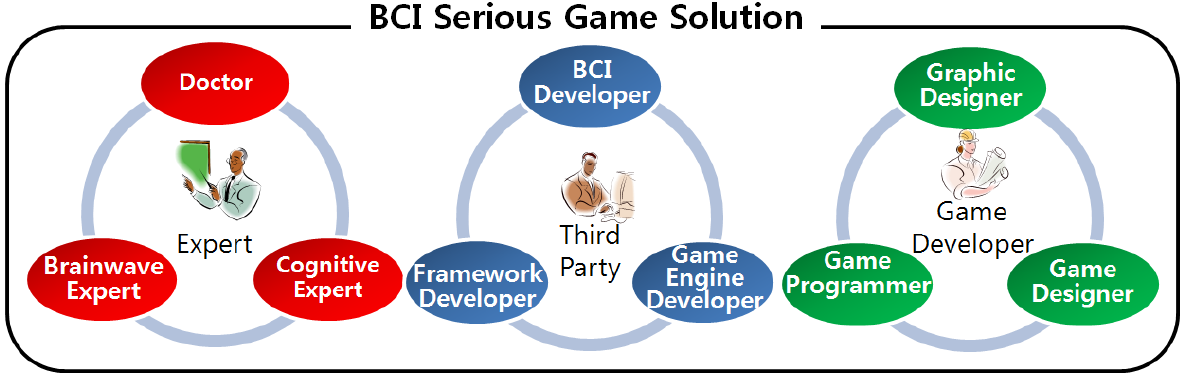
Figure 2. Developers related to BCI Serious Game Development. There are experts, game developers, and third